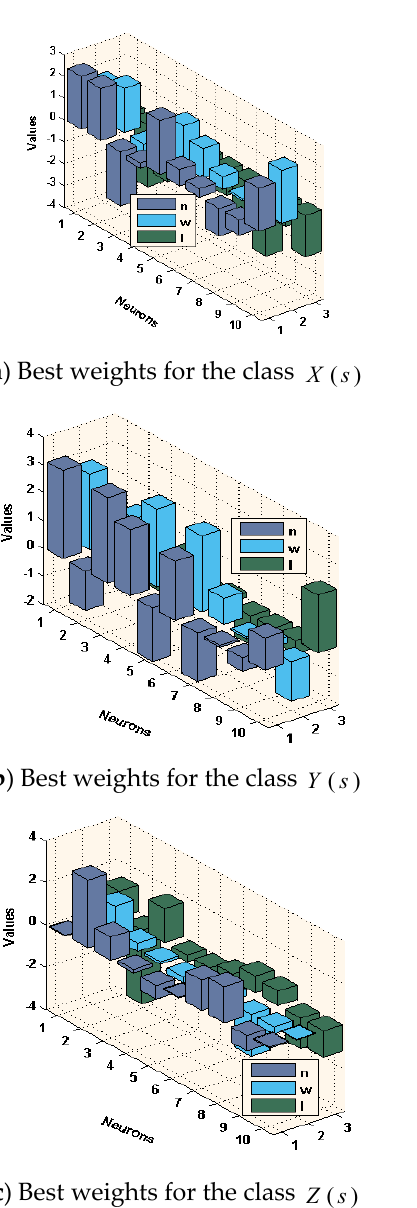
Figure 2. Best values of the weights vectors and results comparison to solve the environmental and economic nonlinear